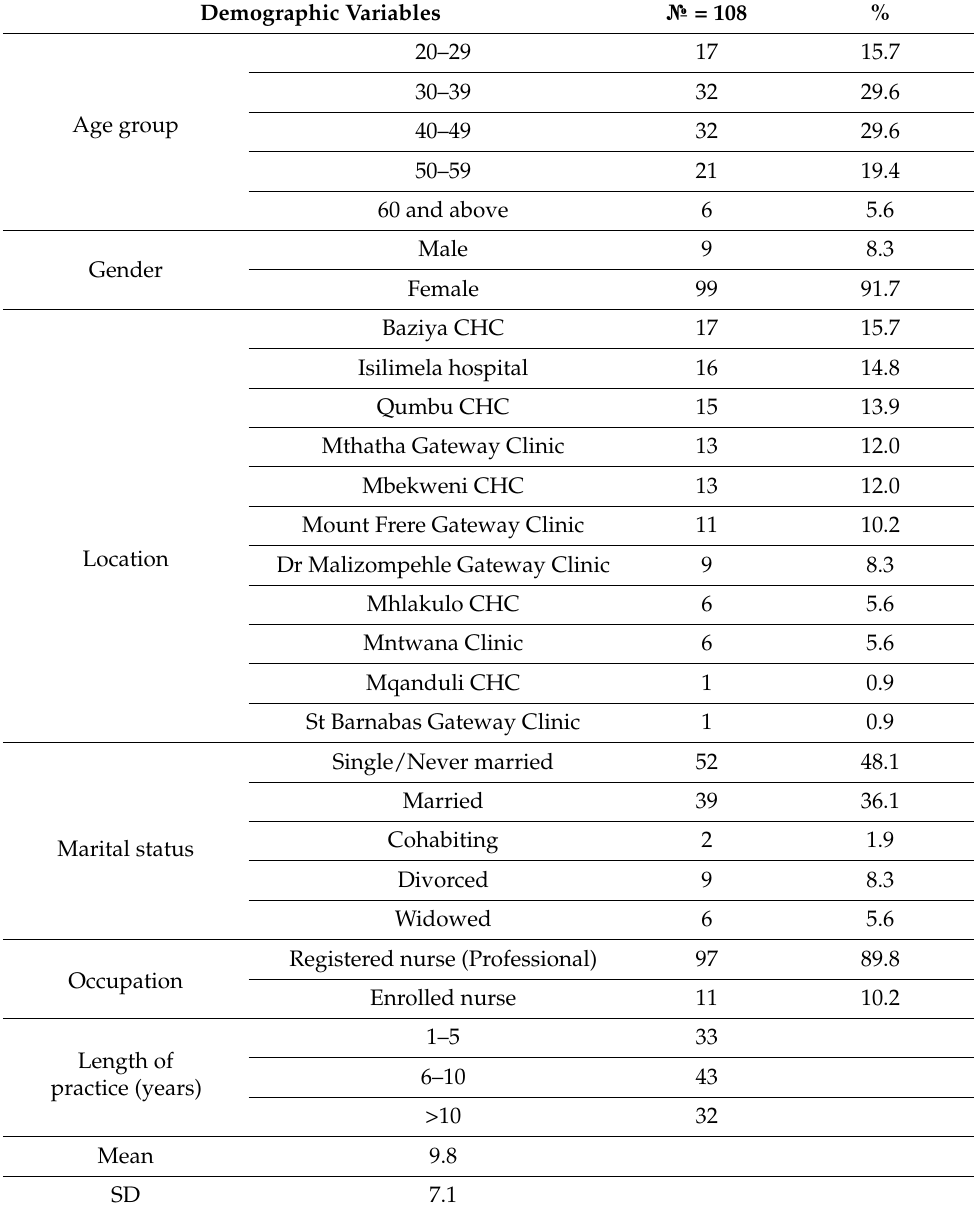
Table 1. Sociodemographic characteristics of healthcare